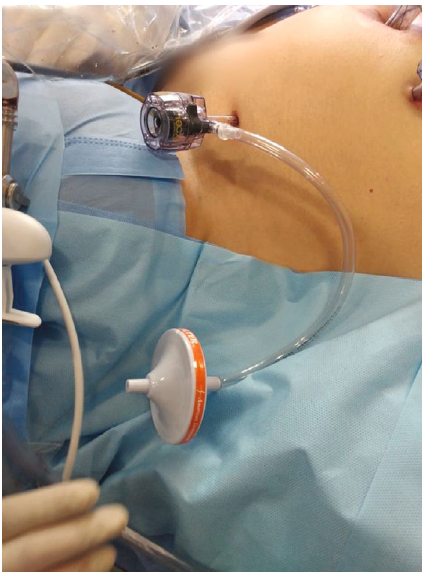
Figure 1: HEPA fi lter systematically used in the exhaust of the arti fi cial pneumoperitoneum and smoke